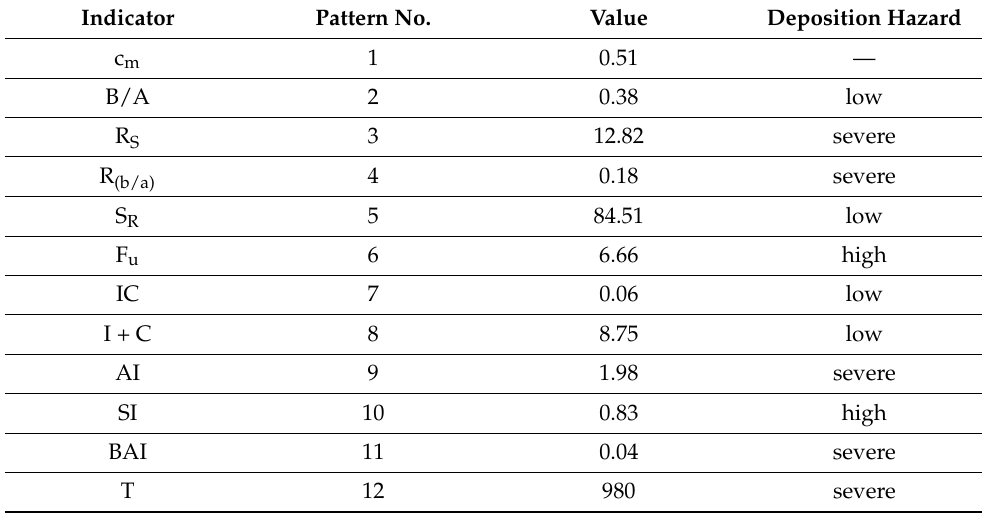
Table 7. Indicators of the assessment of the risk of contamination of heating surfaces of boilers. Indicator Pattern No. Value Deposition Hazard